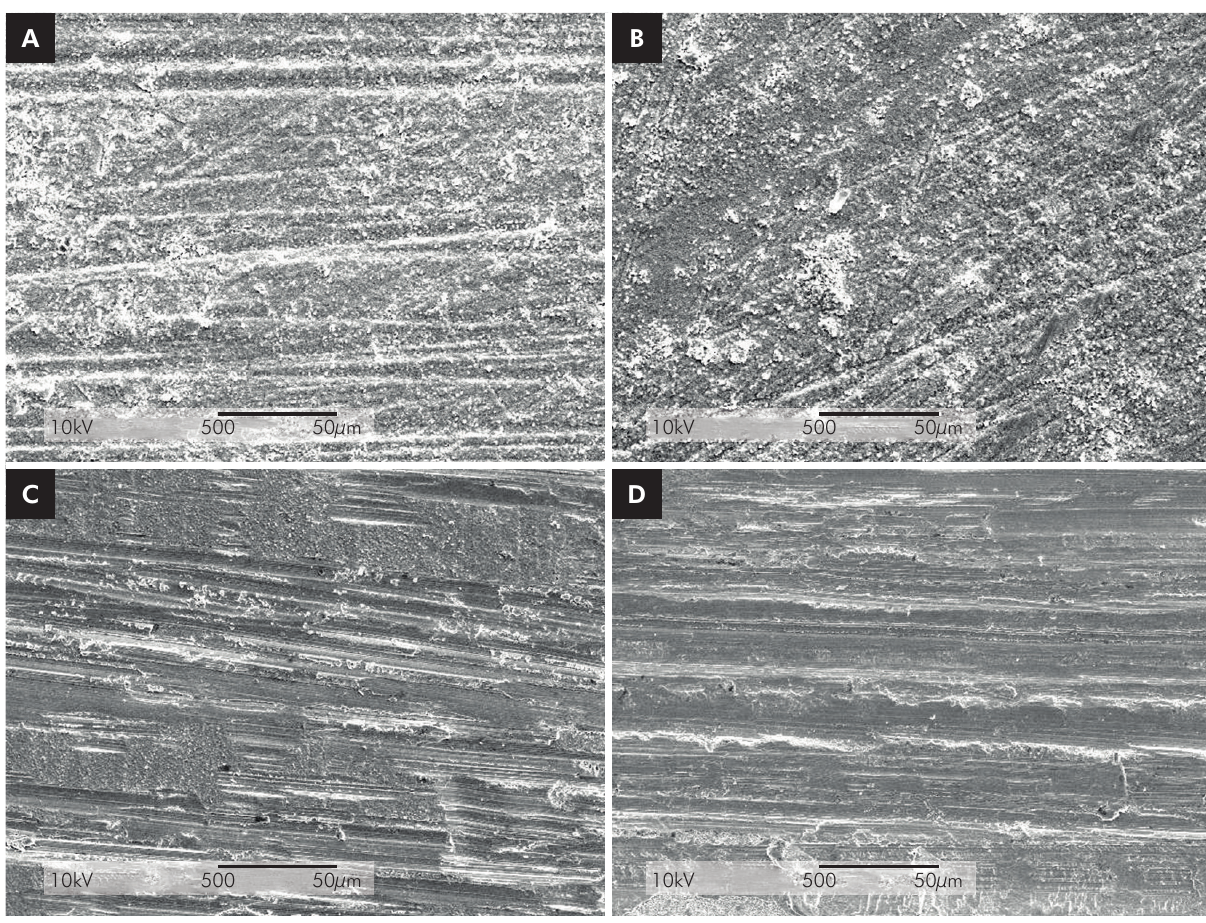
*Different letters indicate statistical differences in the same column.